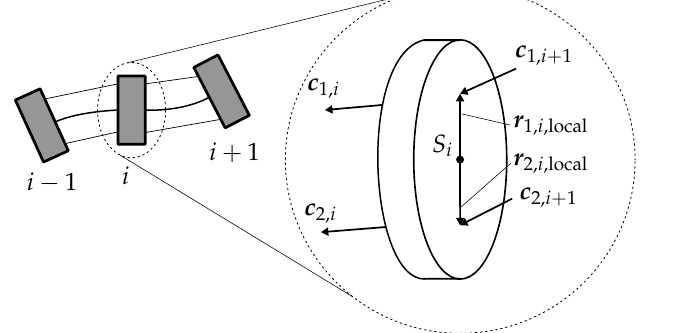
Figure 3. Position of tendon routing points and tendon force vectors on a